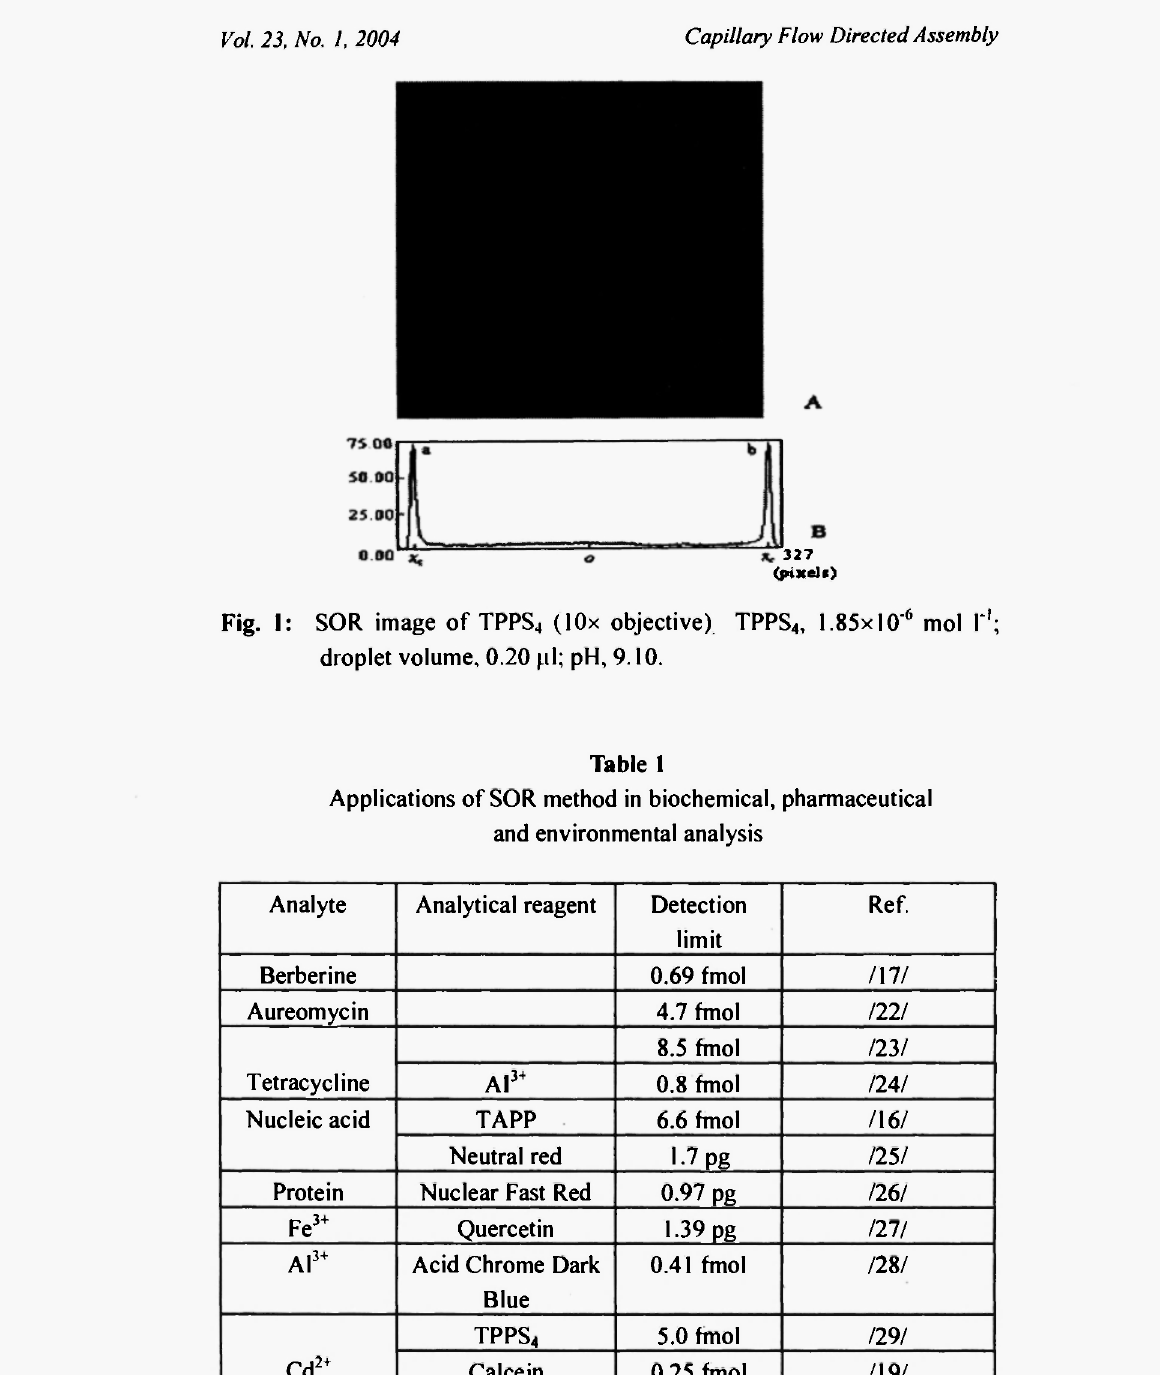
Applications of SOR method in biochemical, pharmaceutical and environmental analysis Analyte Analytical reagent